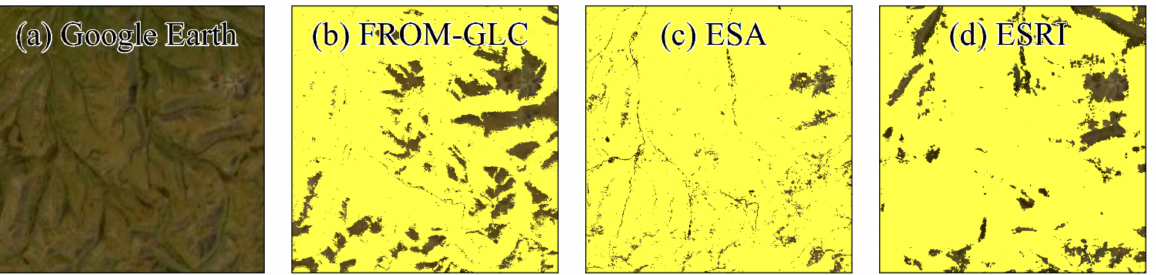
Figure 11. Visual comparison of grassland type with Google Earth image (yellow is grassland):